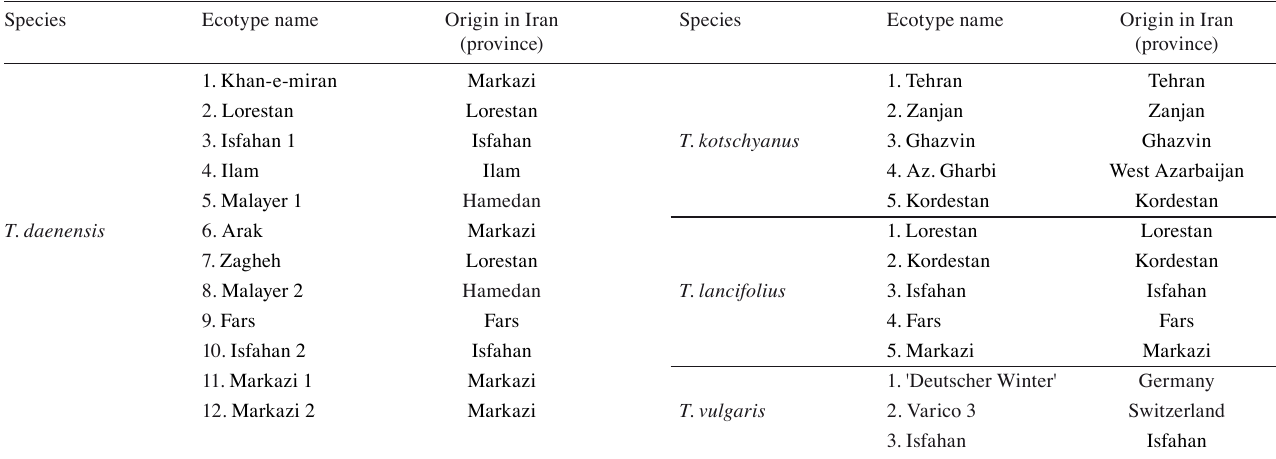
Tab. 1: Plant materials and seed collection origins of thyme